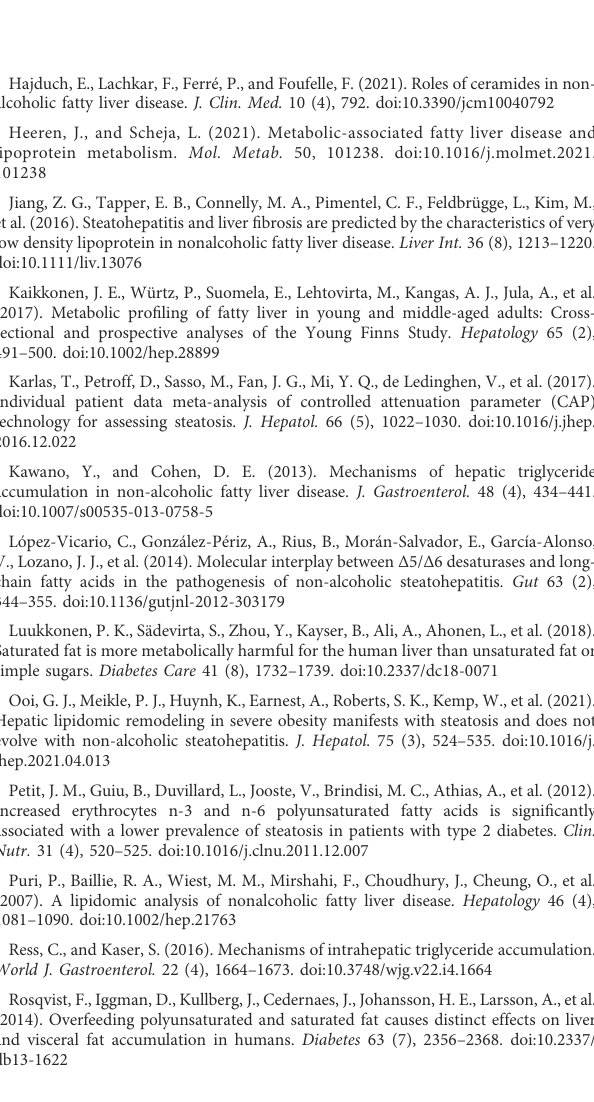
SUPPLEMENTARY TABLE S1 The lipidomic pro fi le of 434 patients with T2DM SUPPLEMENTARY TABLE S2 Subgroup analysis showing effects of antilipemic medications on lipidomic pro fi le of 434 patients with